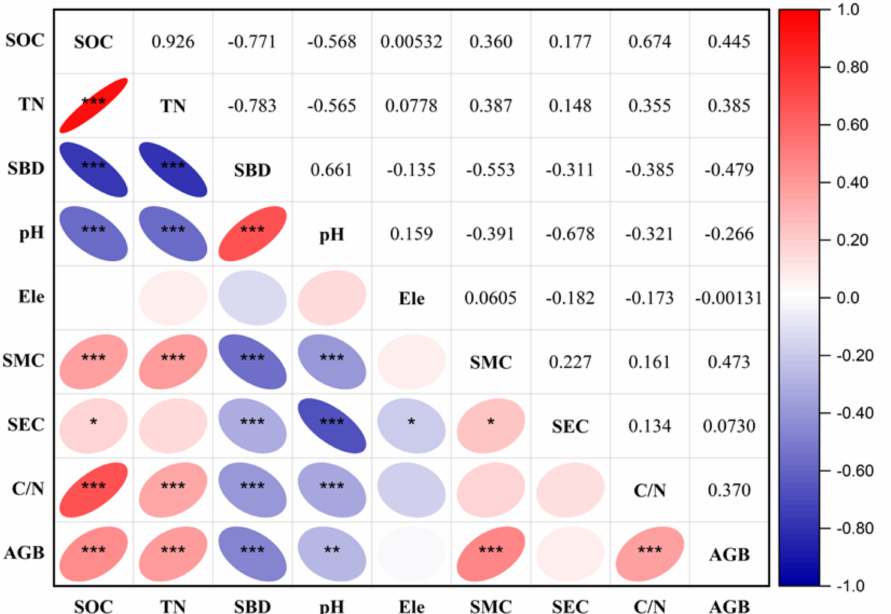
Figure 3. Pearson correlation between environmental factors and soil organic carbon (SOC) and total nitrogen (TN) (Note: red indicates positive correlations, blue indicates negative correlations; “*” indicates the significance correlation at p < 0.05, “**” indicates the significance correlation at p < 0.01, “***” indicates the significance correlation at p < 0.001, and the degree of concentration of ellipse indicates the strength of the correlation; the numbers indicate the correlation degree between variables; SBD = soil bulk density, Ele = elevation, SEC = soil electrical conductivit, SMC = soil moisture content, AGB = aboveground